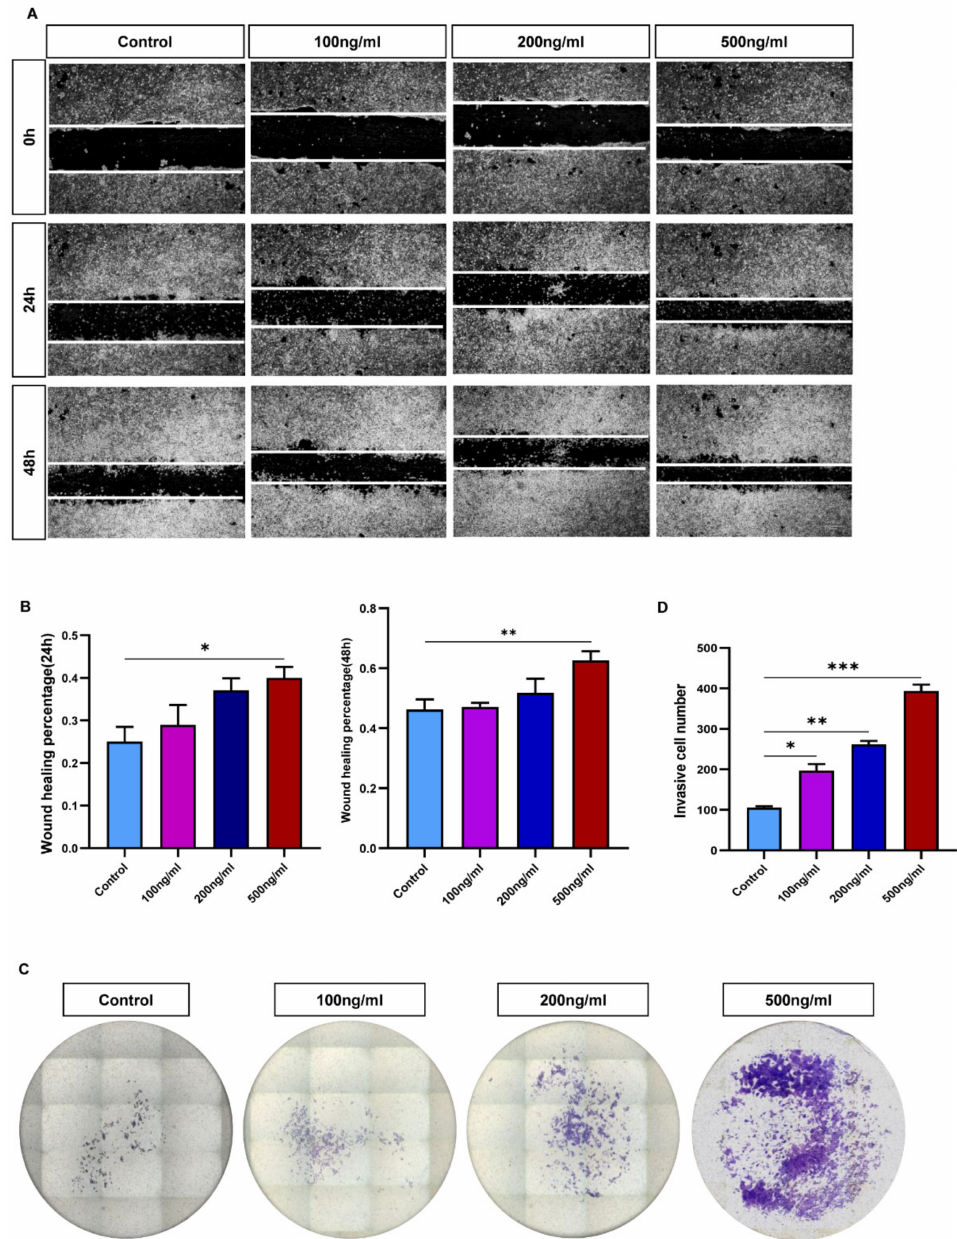
Figure 4. CCL21 promoted trophoblast cell migration and invasion. The HTR8/SVneo cells were treated with 0, 100, 200, and 500 ng/mL of rhCCL21 for 48 h and 24 h, respectively. ( A , B ) Scratch wound-healing assay and quantitation were used to determine trophoblast cell migration ability. ( C , D ) Matrigel invasion assay and quantitation were performed to investigate trophoblast invasive- ness ability; * p < 0.05, ** p < 0.01, *** p <